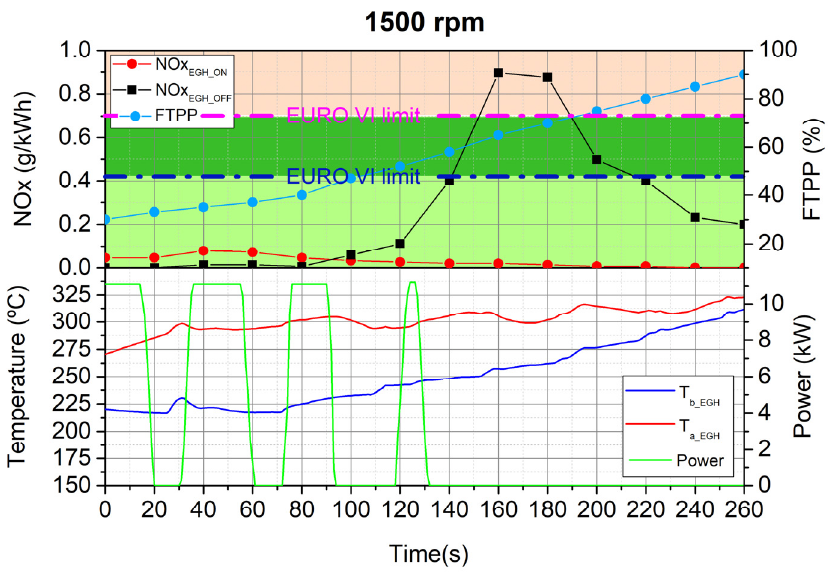
Figure 8. Results from Test 3 including NOx values, FTPP and gas temperatures at 1500 rpm.